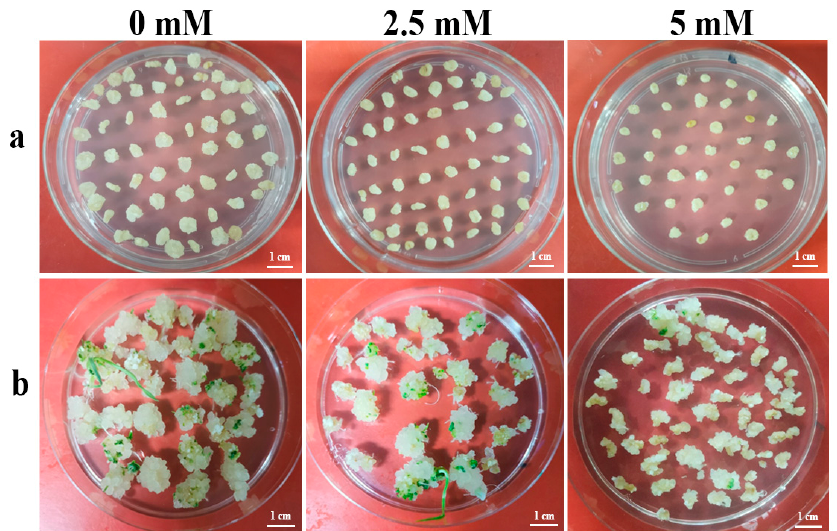
Figure 3. InDel mutations of the TaWaxy gene in the candidate mutants generated from the mature embryos after nicotinamide treatment. The PAM region is underlined; blue letters indicate sgRNA sequences; red letters indicate insertions; dashed lines represent nucleotide deletions.